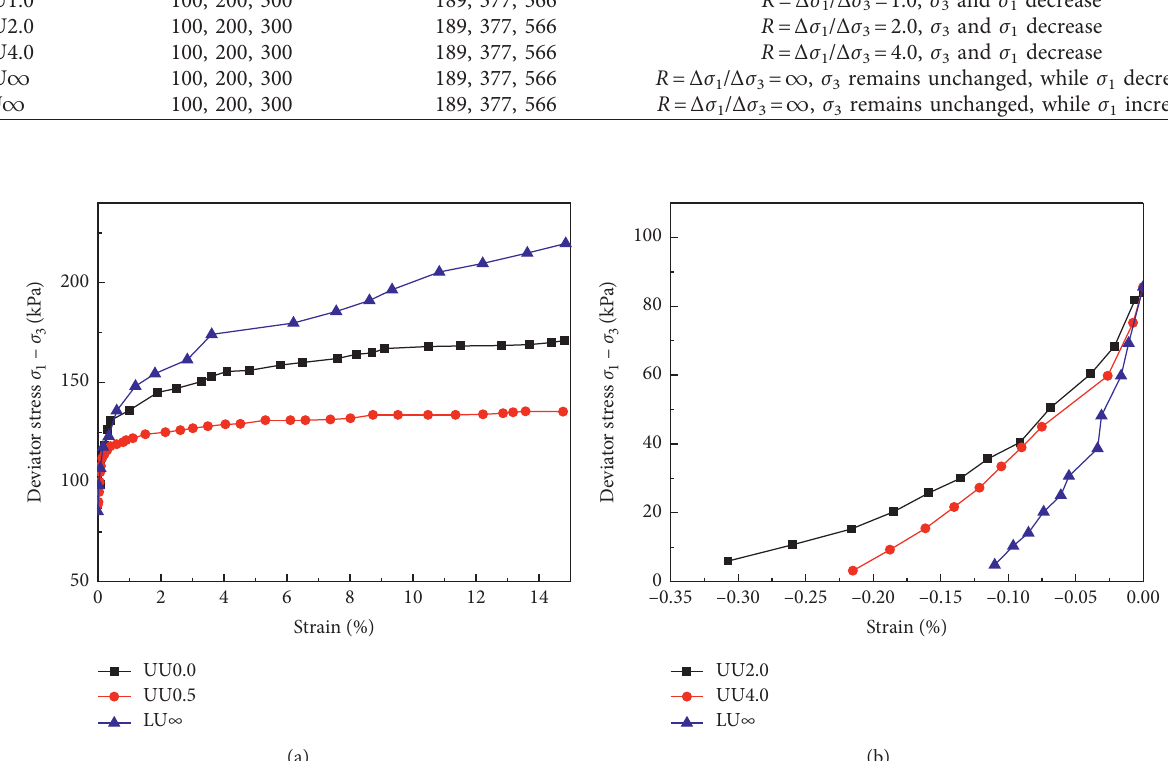
Figure 4: Deviator stress and axial strain (100kPa). (a) Deviator stress and compressive strain. (b) Deviator stress and rebound